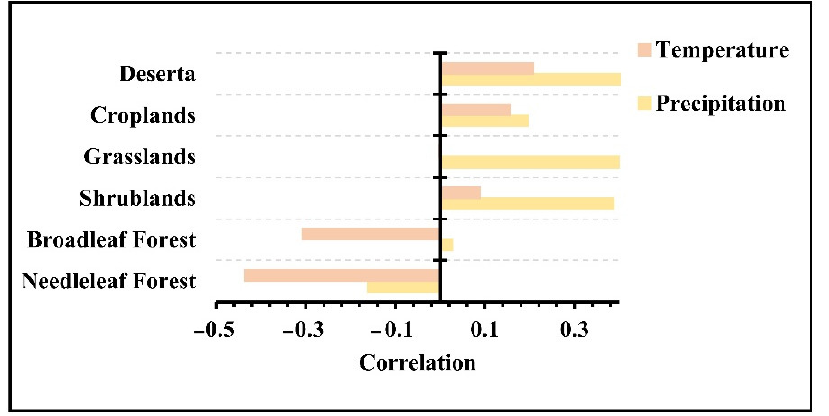
Figure 7. Correlation between the NDVI and climatic factors for different vegetations in China from 1998 to 2019.